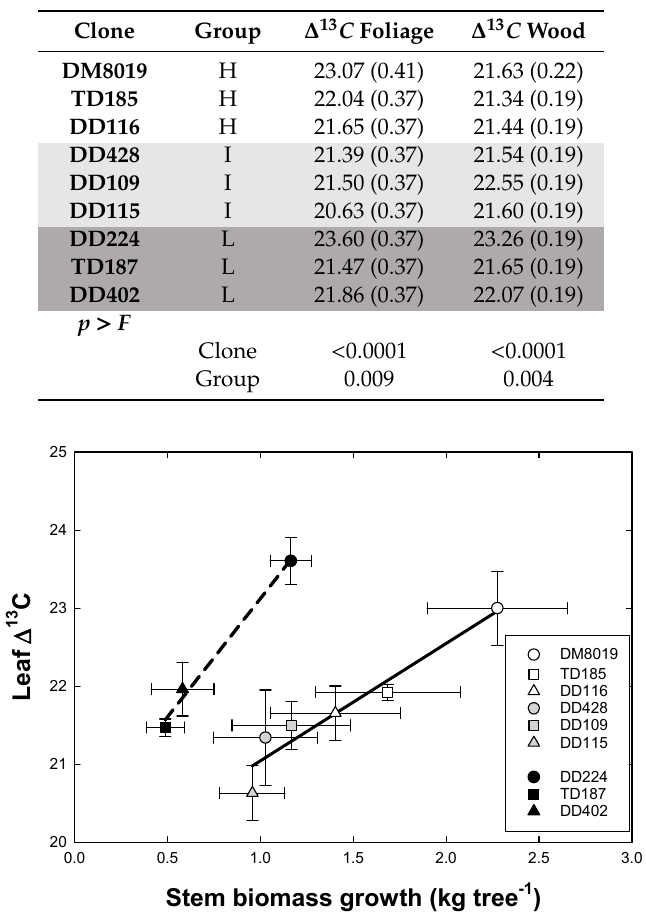
Table 3. Lsmeans (SE) and probability values for foliar and wood ∆ 13 C for nine Populus clones. Genetic crosses are DD: P. deltoides × P. deltoides , DM: P. deltoides × P. maximowiczii , and TD: P. trichocarpa × P. deltoides . Cells with no shading, light shading, or dark shading represent genotypes with high (H), intermediate (I), and low (L) growth potential, respectively.